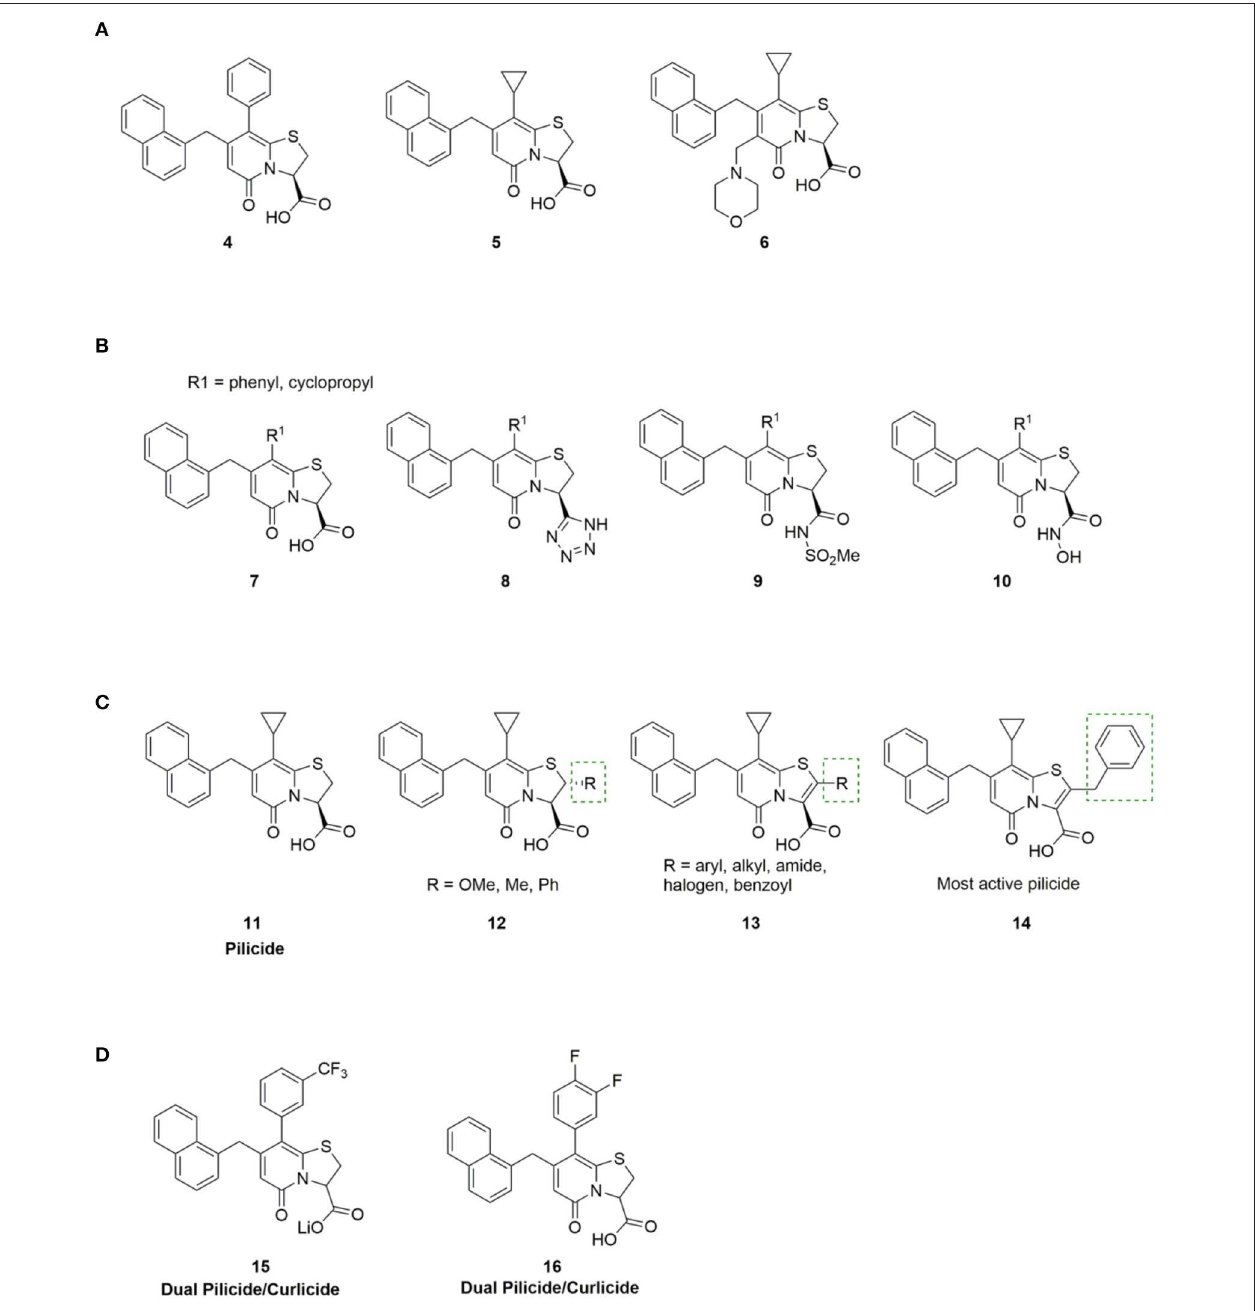
FIGURE 3 | (A) First generation pilicides, compound 4 and 5 (Svensson et al., 2001; Lee, 2003) suffered from low solubility. Aminomethylene substitution of pilicide 5 resulted in compound 6 with improved solubility properties (Hedenstrom et al., 2005). (B) Pilicides containing carboxylic acid isosteres, including tetrazoles ( 8 ), acyl sulfonamides ( 9 ) and hydroxamic acids ( 10 ) are tolerated (Åberg et al., 2008). (C) SAR study to investigate substitution of position C-2 in the pilicide scaffold, including both saturated ( 12 ) and unsaturated ( 13 ) analogs (Chorell et al., 2010). (D) Small modifications in the phenyl ring allowed identification of ring-fused 2-pyridones that exhibit dual pilicide-curlicide activity (Cegelski et al.,